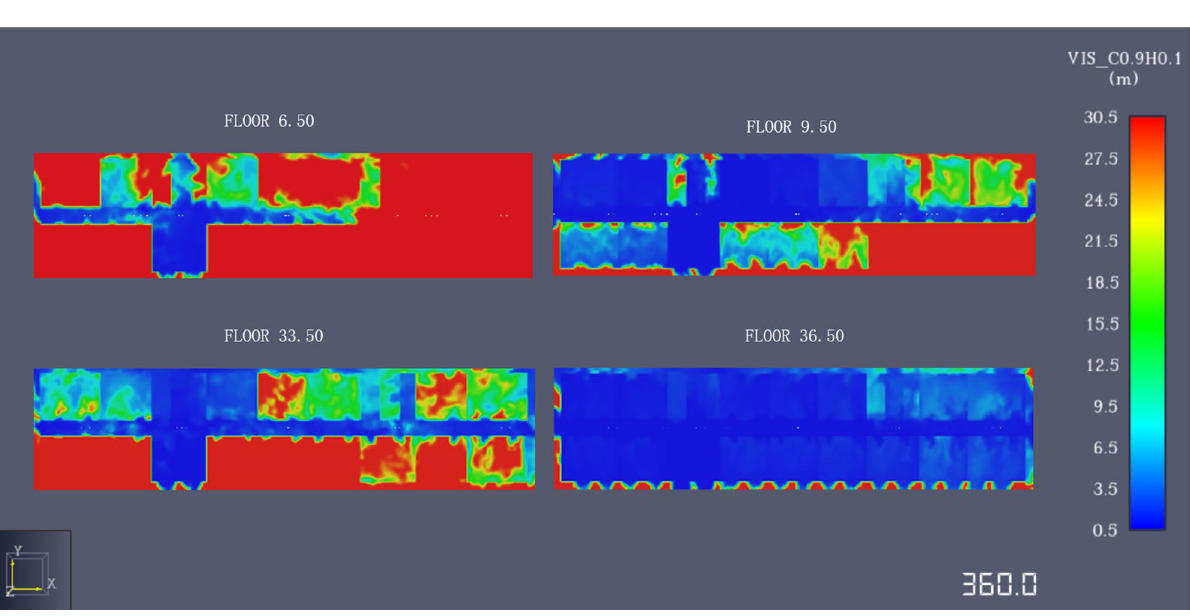
Figure 12. Slice diagram of visibility